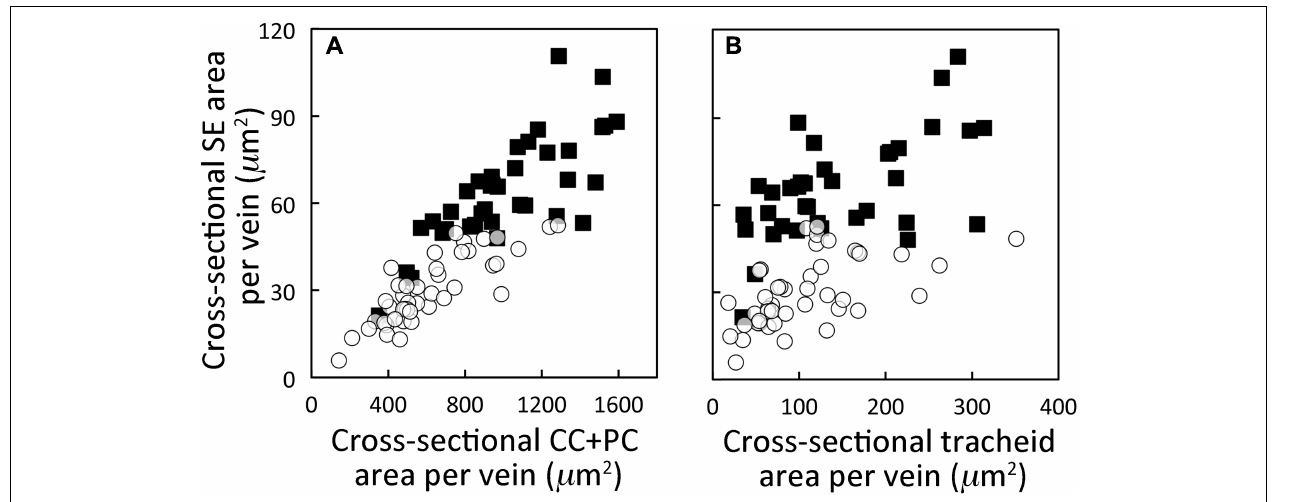
FIGURE 2 | Relationship between the cross-sectional area of the sieve elements (SE) versus (A) the cross-sectional area of the companion and phloem parenchyma cells immediately adjacent to those sieve elements and (B) the cross-sectional area of the tracheids in foliar minor loading veins of A. thaliana Italian (open circles) and Swedish (black squares) ecotypes grown in controlled temperature (12–16 ◦ C daytime leaf